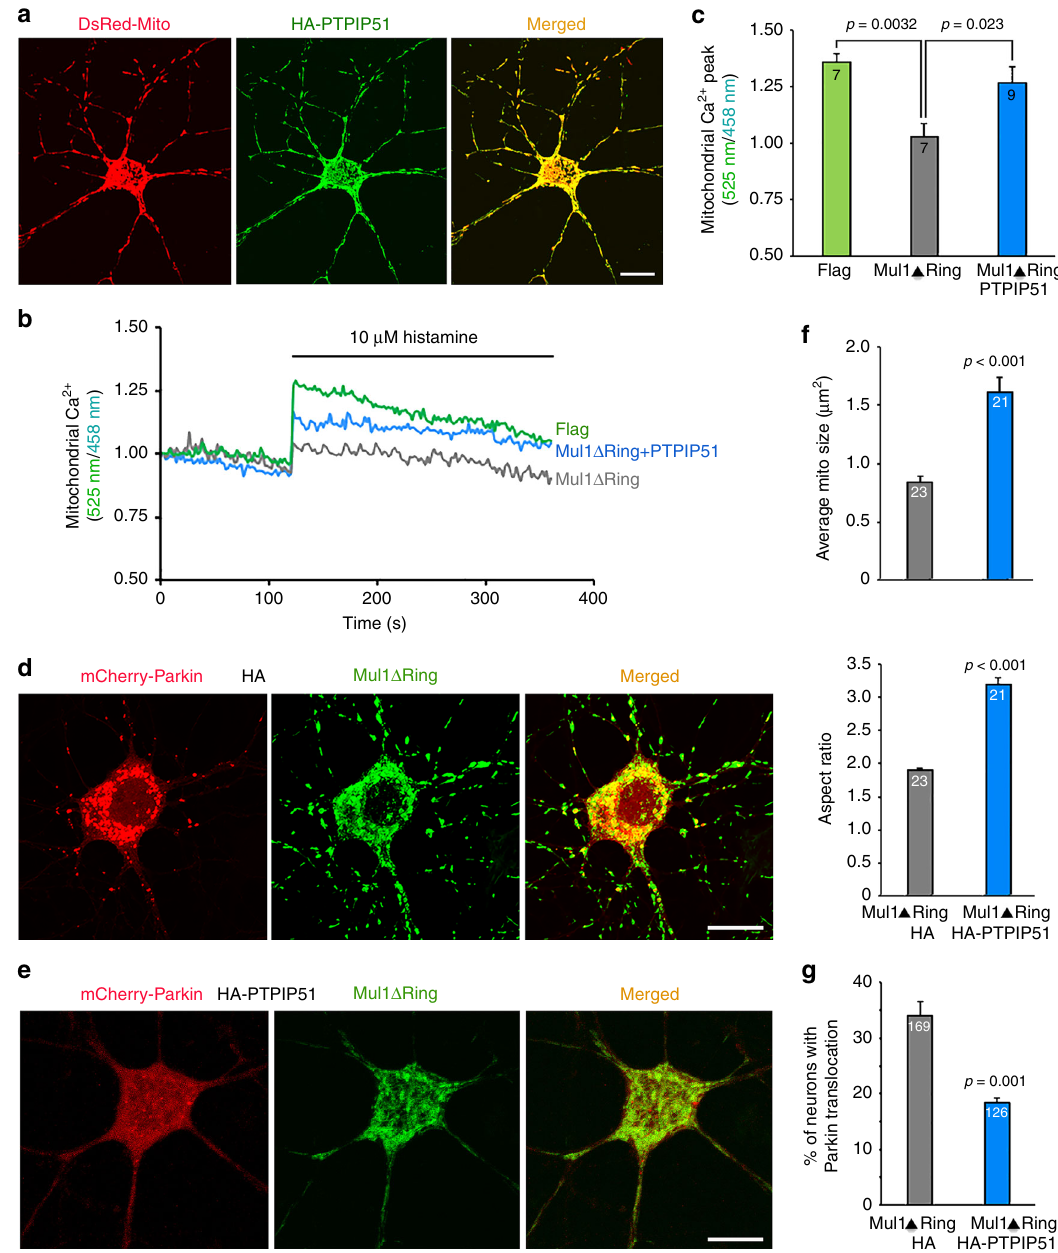
Fig. 9 Expressing PTPIP51 suppresses mitochondrial fragmentation and Parkin translocation in Mul1-de fi cient neurons. a Representative images showing the mitochondria-targeting of PTPIP51 in cortical neurons. Neurons were co-transfected with HA-tagged PTPIP51 and DsRed-Mito at DIV7-8 and imaged at DIV10-11 by immunostaining HA-tag. b , c Representative traces and quantitative analysis showing a partial rescue of IP3-induced ER-Mito Ca 2 + exchange by expressing PTPIP51 in Mul1-de fi cient neurons. Cortical neurons at DIV7-8 were co-transfected with pcDNA-4mtD3cpv and Flag, or Flag-Mul1 Δ Ring, or Flag-Mul1 Δ Ring + HA-PTPIP51. pcDNA-4mtD3cpv is a FRET-based ratiometric calcium probe that targets the mitochondrial matrix. Live neurons were imaged at DIV10-11. The traces represent the average fl uorescence ratio signal (525 nm/458nm) when excited with a 405-nm laser following stimulation with 10 μ M histamine. Mitochondrial Ca 2 + levels were measured from the total number of trials indicated in the bars. Each trial denotes 2 – 3 neurons per fi eld. d – g PTPIP51 expression suppresses mitochondrial fragmentation and reduces Parkin translocation in Mul1-de fi cient neurons. Cortical neurons at DIV7-8 were co-transfected with mCherry-Parkin, Flag-Mul1 Δ Ring, and HA-Vector ( d ) or HA-PTPIP51 ( e ), followed by immunostaining with Flag-tag (green) at DIV14-15. The mitochondrial morphology was measured as average mitochondria size and aspect ratio from the total number of neurons indicated in the bars ( f ); the percentage of neurons with Parkin recruitment to fragmented mitochondria was measured from the total number of neurons indicated in the bars ( g ). All data were from three experiments using the unpaired Student ’ s t -test ( f, g ) and Ordinary one-way ANOVA with Dunnett ’ s post hoc test ( c ) and are expressed as mean ± s.e.m. Scale Bars: 10 μ